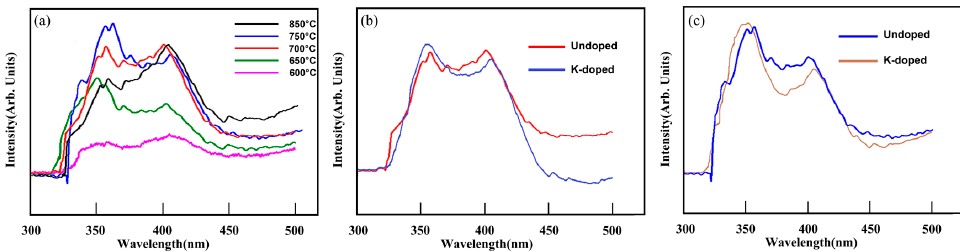
Figure 6. The PL spectrums of WO 3 NWs synthesized at different temperature zones. ( a ) From 600– 850 °C. The undoped and K-doped NWs grown at ( b ) 750 °C and ( c ) 700 °C.